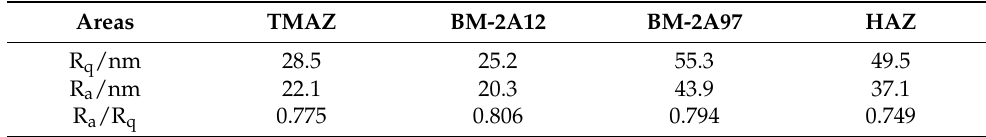
Figure 6. AFM images of CSA-LDH-PF film on the different FSW joint areas. ( a ) HAZ, ( b ) NZ, ( c ) TMAZ, ( d ) BM-2A12 and ( e ) BM-2A97. Table 4. Roughness of the CSA-LDH-PF film on different areas of the FSW joint (R q : r.m.s roughness, R a : mean roughness).